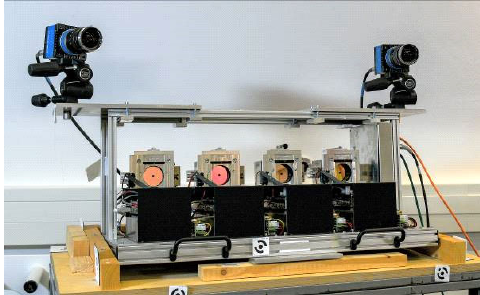
Figure 8. High-speed cameras mounted on fan-shaped distance meter system